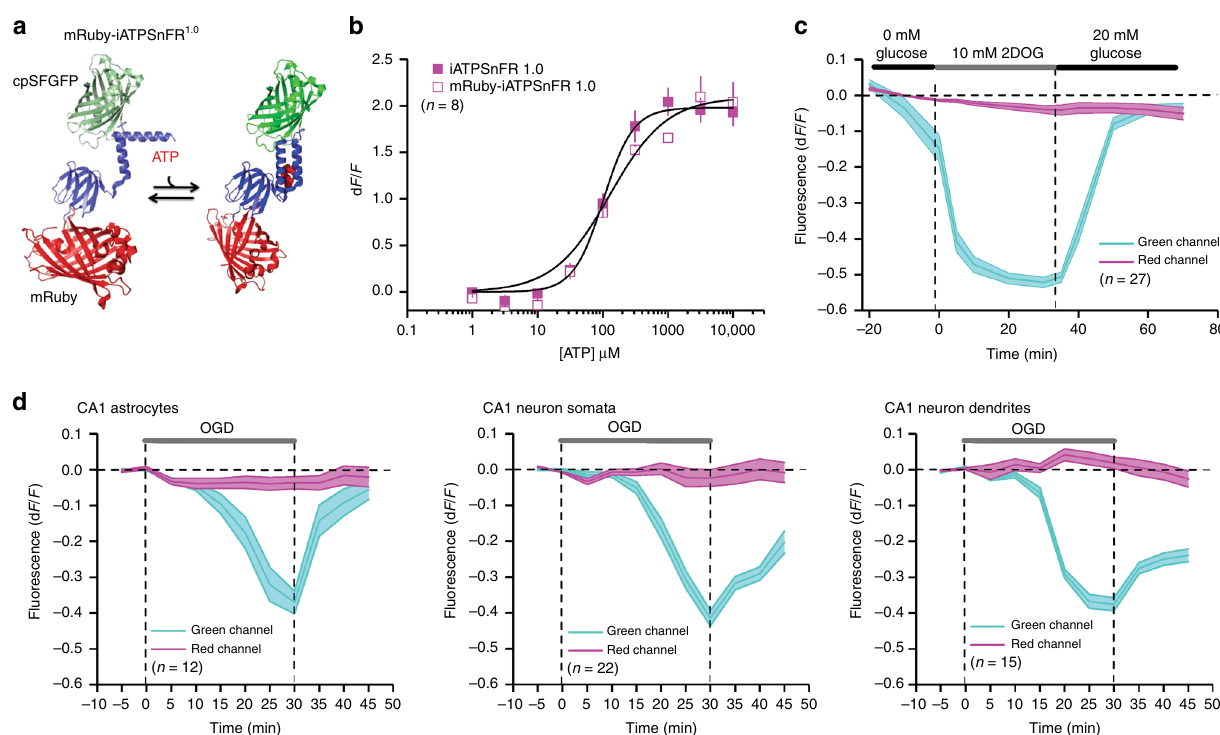
Fig. 6 Characterization of cytosolic mRuby-iATPSnFR 1.0 . a Cartoon schematic of mRuby-iATPSnFR 1.0 : ATP binding is schematized to show an increase in cpSFGFP fl uorescence, whereas mRuby fl uorescence remains unchanged. b Dose – response curves for iATPSnFR 1.0 in relation to mRuby-iATPSnFR 1.0 in HEK293 cell lysates. c Changes in fl uorescence of mRuby-iATPSnFR 1.0 (green and red channels) before, during, and after inhibition of glycolysis with 2DOG in HEK293 cells. d Changes in fl uorescence of mRuby-iATPSnFR 1.0 (green and red channels) during oxygen-glucose deprivation in hippocampal brain slices. Data from astrocytes as well as CA1 pyramidal neuronal cell bodies and dendrites are shown. The error bars represent the s.e.m. and in some cases are smaller than the symbols used for the mean. n numbers are provided in the fi gure panels and refer to the number of